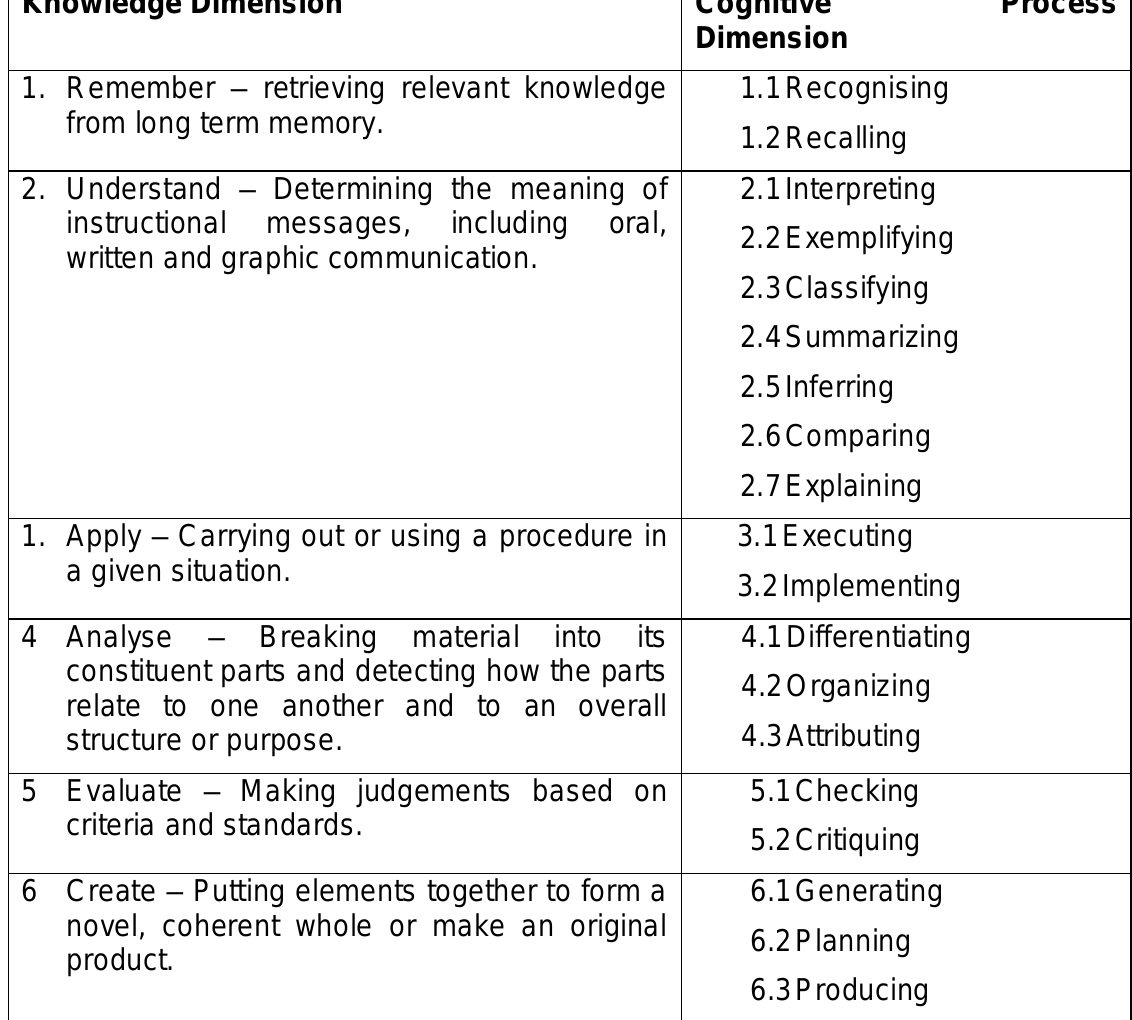
Table 2.2: The Taxonomy Table Knowledge Dimension Cognitive Process